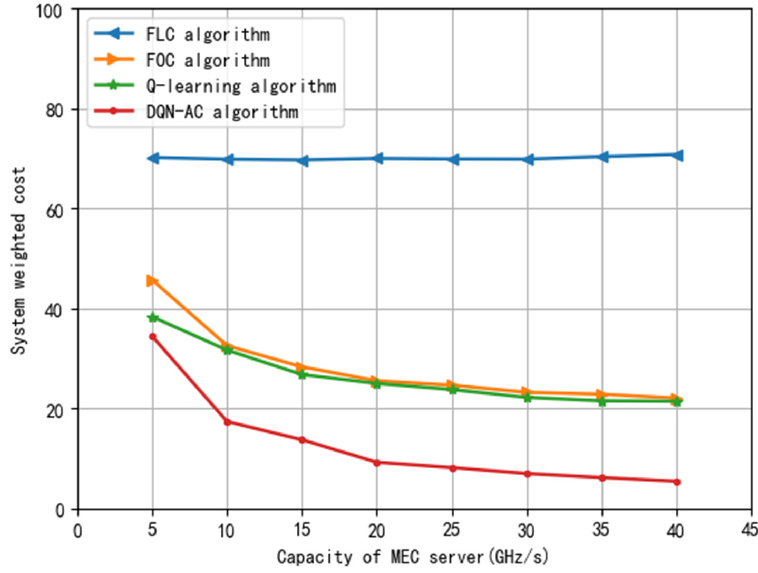
Figure 4. The impact of MEC server capacity on system weighted cost.